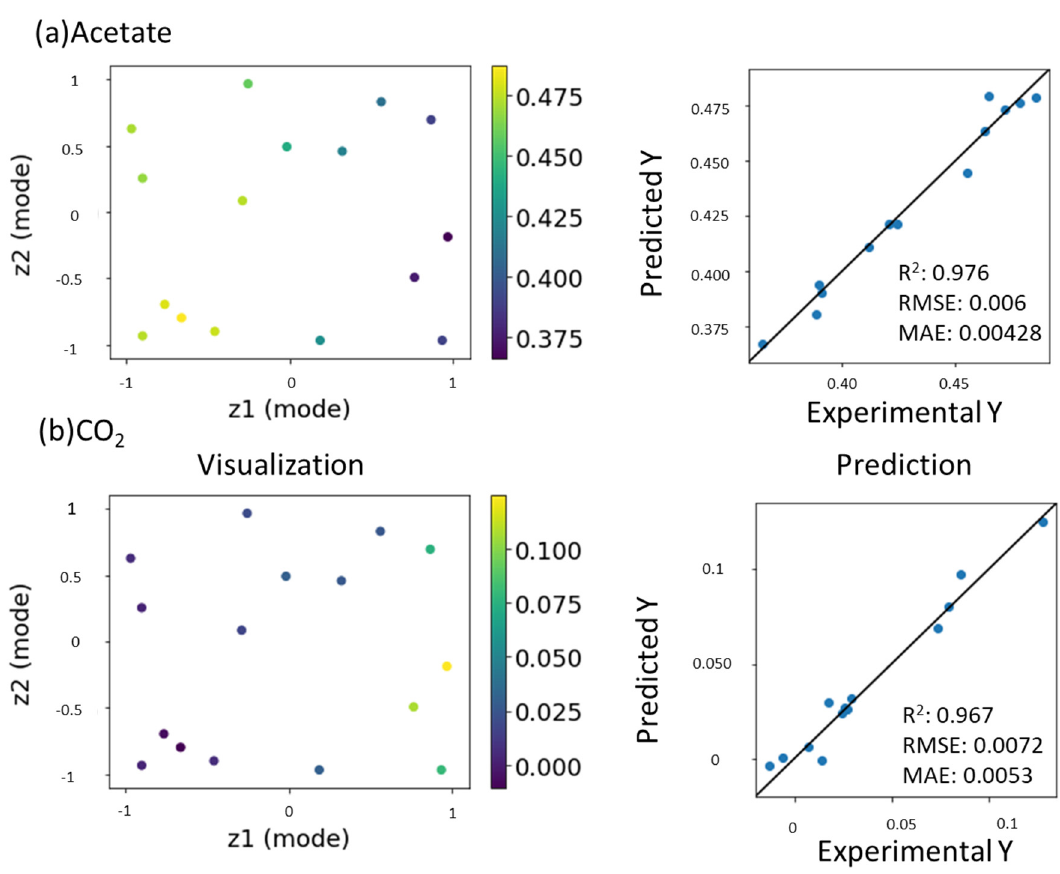
Figure 4. Application of GTMR to NMR data in the cellulose degradation process. ( a ) Visualization and prediction of the concentration of acetate. ( b ) Visualization and prediction of the concentration of CO 2 .